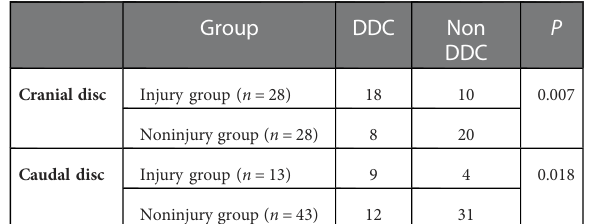
TABLE 1 The impact of cranial and caudal endplate injury on DDC (number of